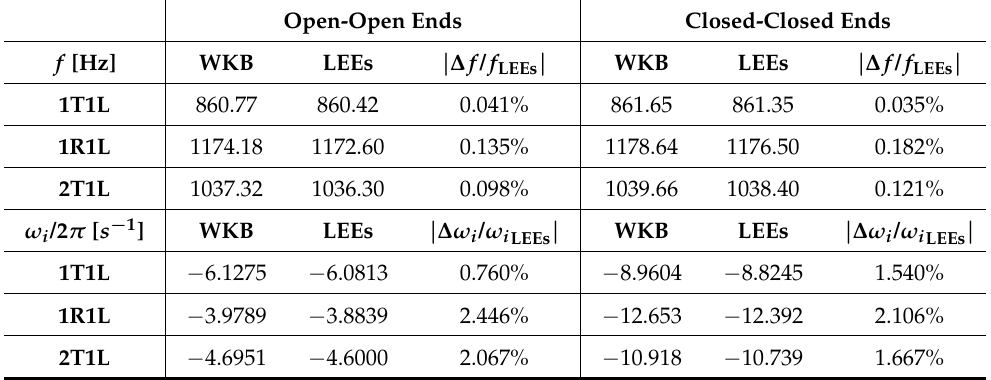
Table 2. Predicted resonant frequencies for the three transverse modes with different boundary conditions. Open-Open